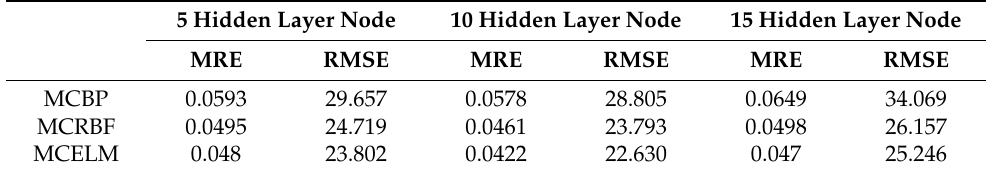
Table 4. Comparison of overall errors.